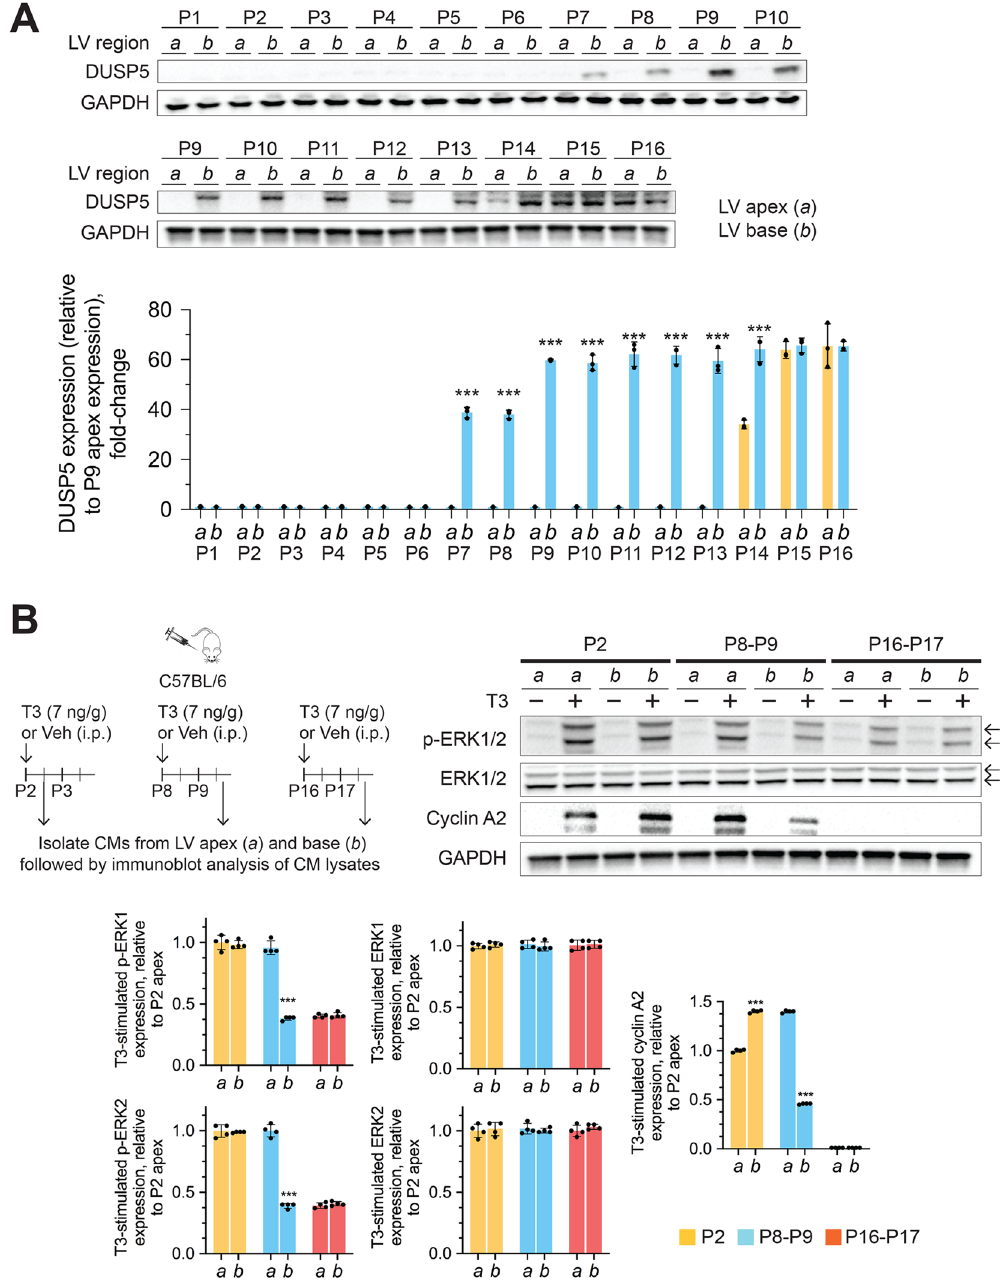
Figure 6. Spatio-temporal changes in LV DUSP5 levels and T3-stimulated ERK1/2 phosphorylation in cardiomyocytes in postnatal mice. ( A ) Representative immunoblots showing developmental changes in myocardial DUSP5 levels in the LV apex ( a ) and base ( b ) of early postnatal hearts. Bar graphs show GAPDH normalized quantitative data relative to DUSP5 levels in apical tissue of the P9 LV myocardium. ( B ) Representative immunoblots showing expression of the indicated proteins in whole cell lysates prepared from cardiomyocytes (CMs) of the LV apex and base of P2 (neonatal), P8 (early preadolescent) and P16 (preadolescent) hearts, both with and without in vivo T3 treatment. The upper and lower arrows indicate the position of ERK1 and 2, respectively. Bar graphs show T3 stimulated, GAPDH normalized, protein expression, relative to expression in P2 LV apex derived CMs. Immunoblots are representative of 3 (A) or 4 (B) biologically independent replicates. Schematics illustrate the experimental protocol. Data are means ± SEM. Comparisons between apex and base LV tissue samples were made using a paired 2-tailed Student’s t -test, with n = 3 or 4 pairs at each time